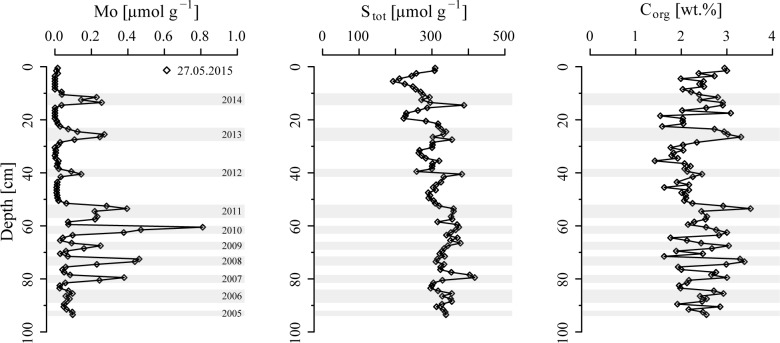
Vertical profiles of sedimentary Mo, total solid phase S and Corg.Grey bars indicate sediments that are enriched in Mo relative to the background, which is assumed to reflect periods of seasonal hypoxia in Lake Grevelingen.